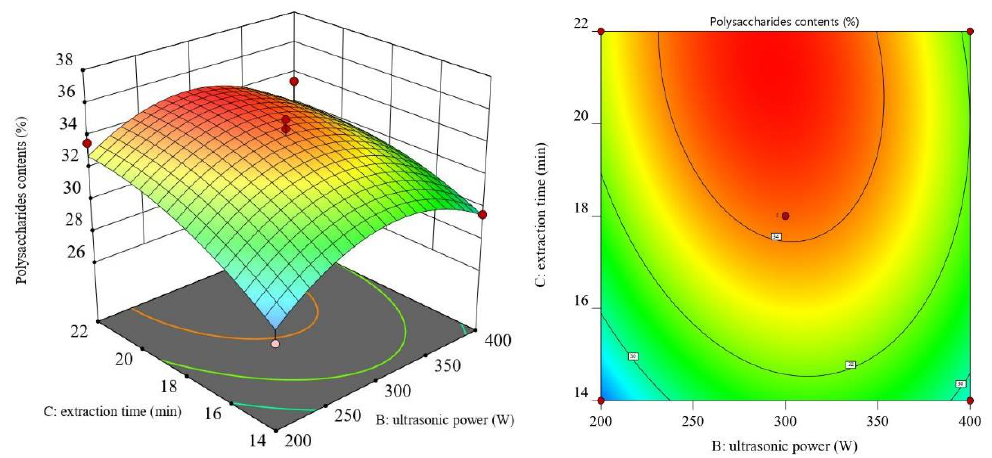
Figure 5. Effect of the interaction of microwave power and liquid-to-material ratio on polysaccharide yield. (A is the microwave power/(W), D is the liquid-to-material ratio/(g/mL)).